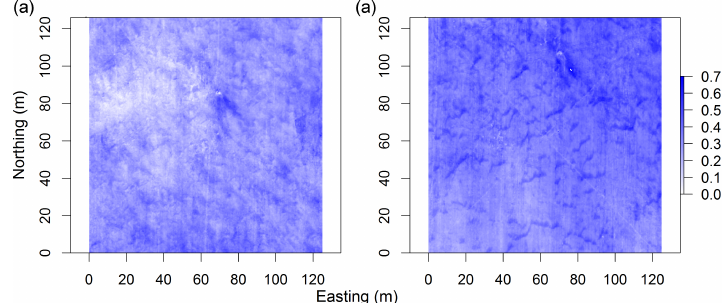
Figure 6. Bias corrected distributed snow depth (m) for (a) short and (b) tall stubble treatments at peak snow depth (10 March 2015) at the prairie